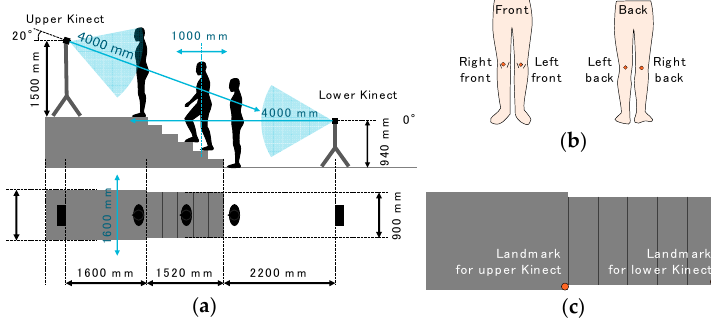
Figure 4. ( a ) Experimental setup; ( b ) positions of markers on a subject; ( c ) positions of markers on stairs as landmarks. Table 1. Characteristics of the subjects.